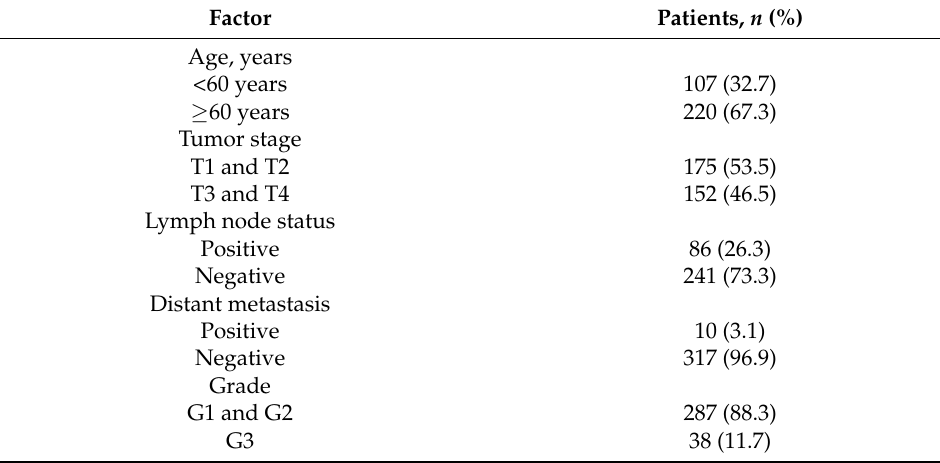
Table 1. Frequency data for patients clinicopathological factors.